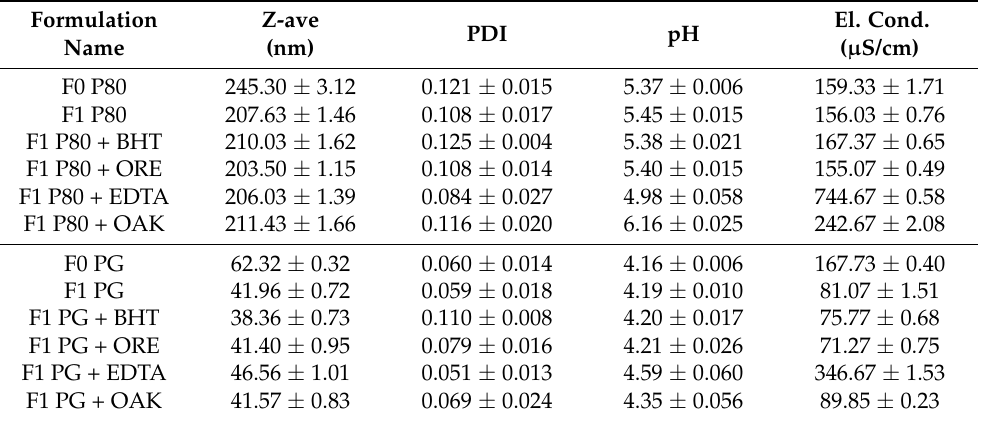
Table 2. Z-average droplet size (Z-ave), polydispersity index (PDI), pH value, and electrical conduc- tivity (El. cond.) of nanoemulsions stabilized with different surfactants and antioxidants.